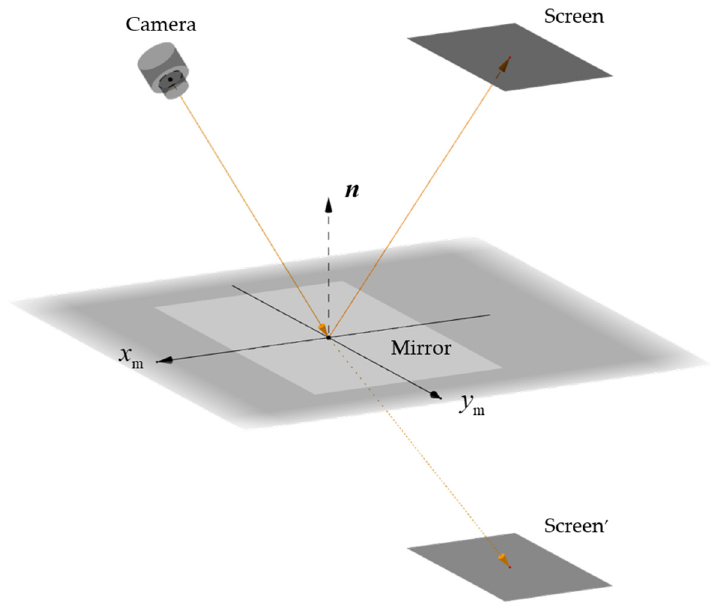
Figure 1. The schematic diagram of monoscopic phase measuring deflectometry. Coordinate transformations are necessary for this work to construct the SPG model.